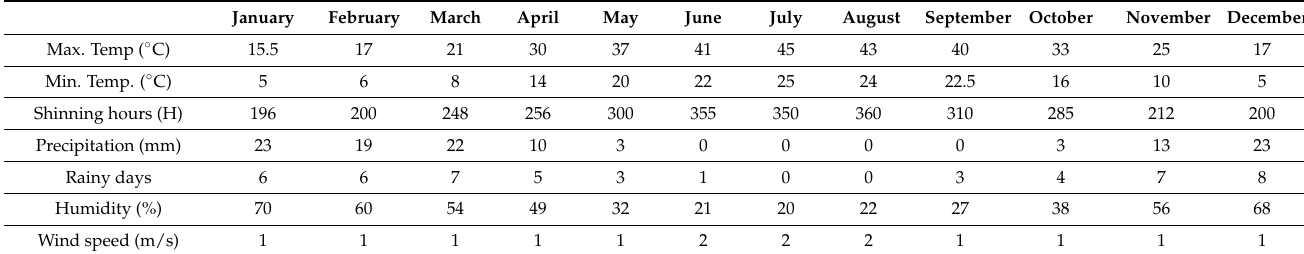
Table 2. Average weather conditions per month for Baghdad city